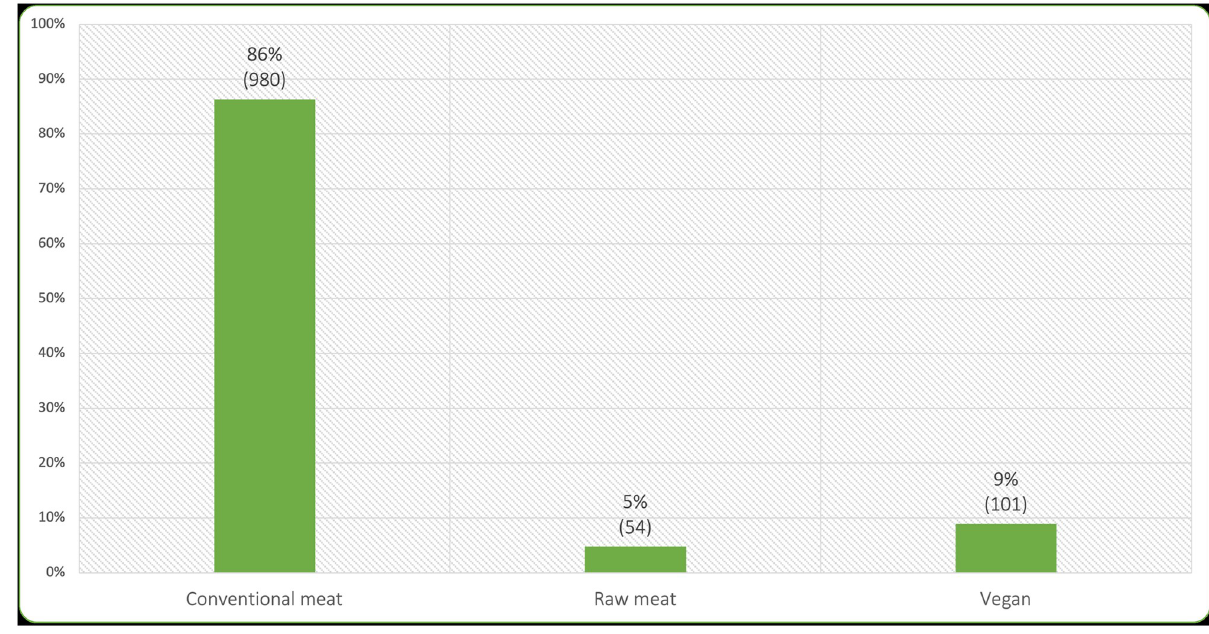
Fig 3. Diets of 1,135 sampled cats.